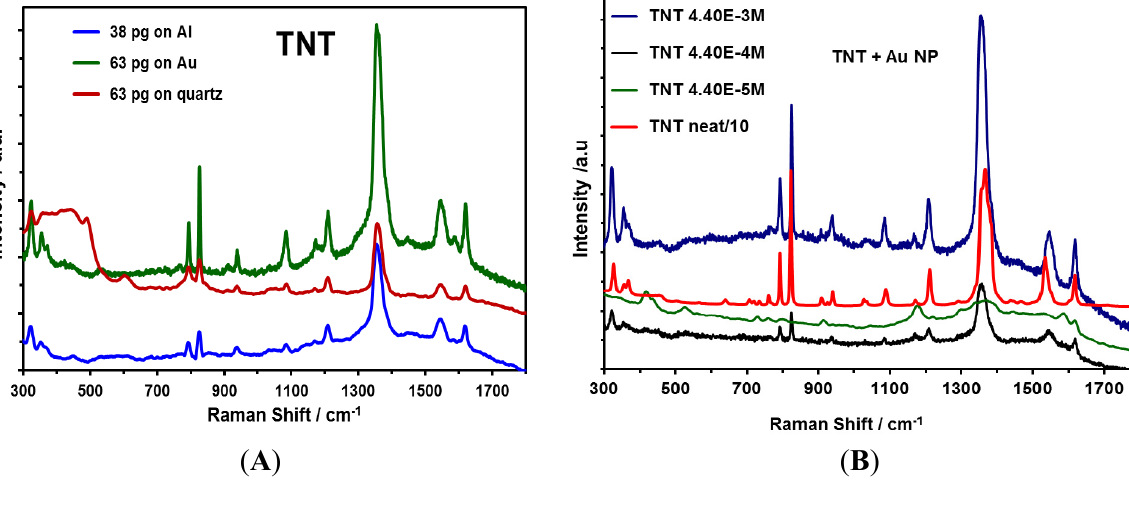
Figure 7. SERS spectra of TNT deposited on Au NPs; spectra were taken at 785 nm: ( A ) NPs were deposited on different substrates (Al film, Au film and quartz); ( B ) TNT deposited at different concentrations and Al was used as the